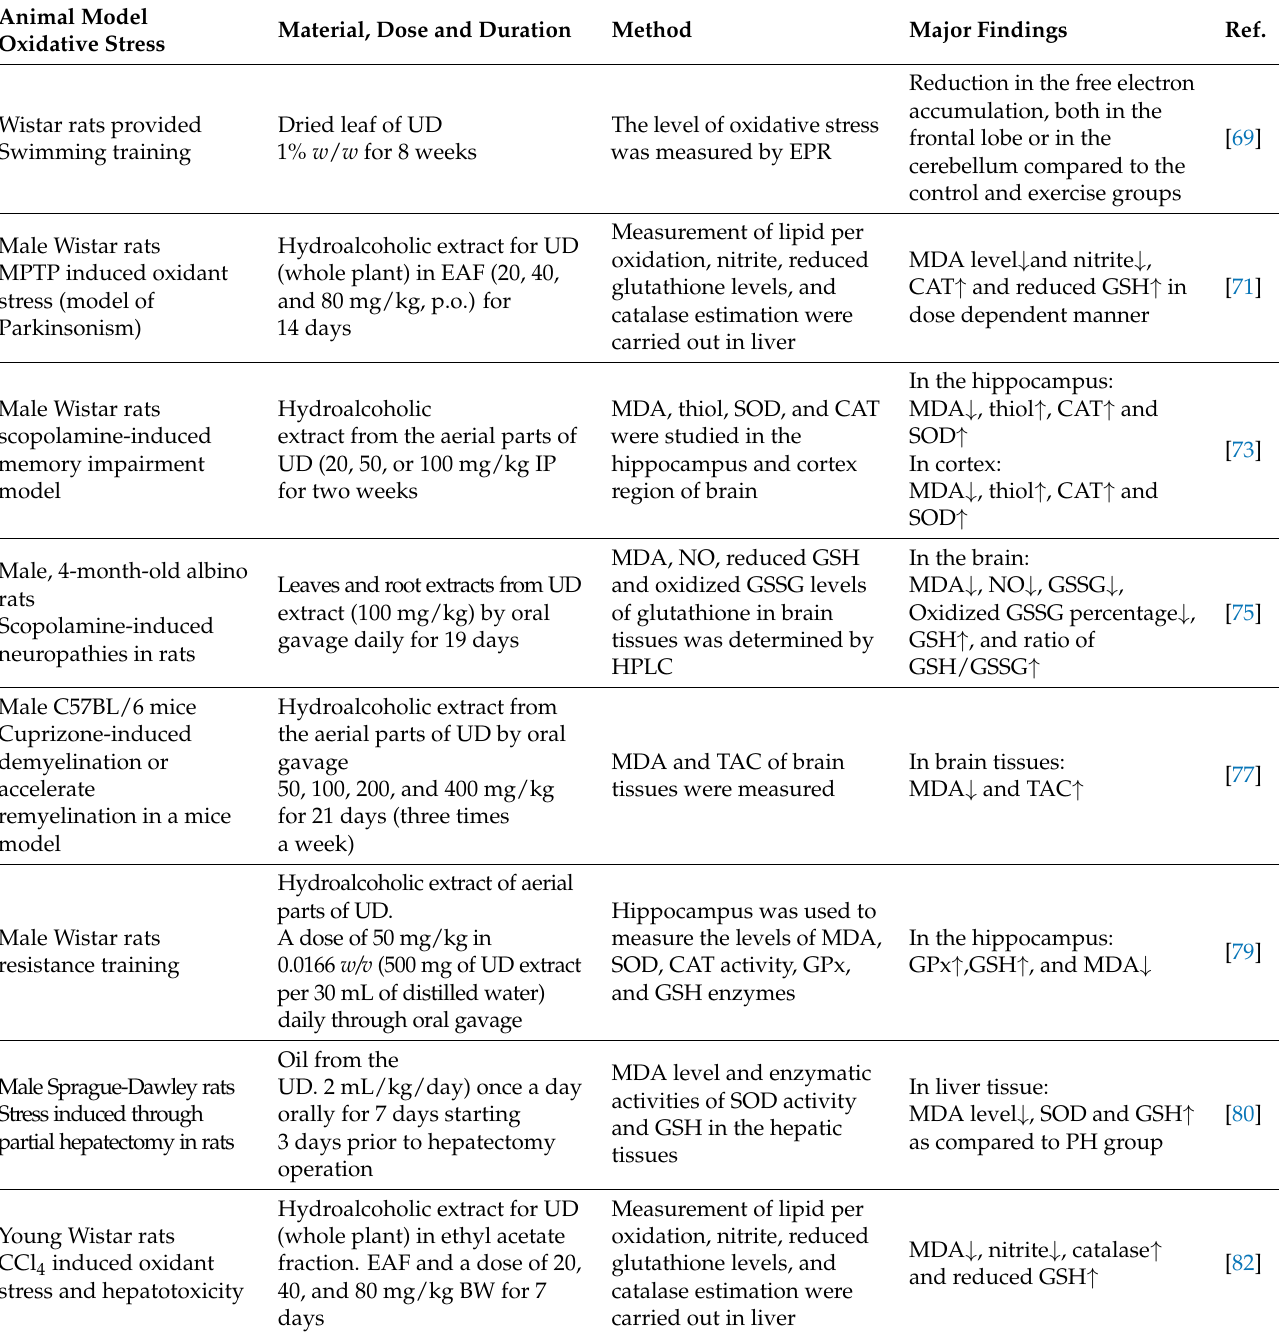
Table 2. Antioxidant activities of UD through in vivo